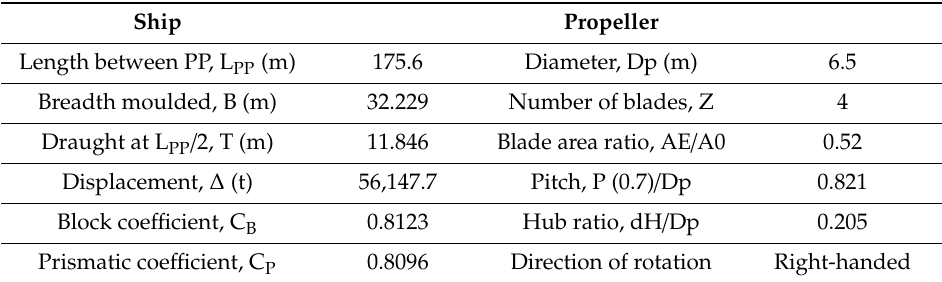
Table 4. Conditions for PSS design.